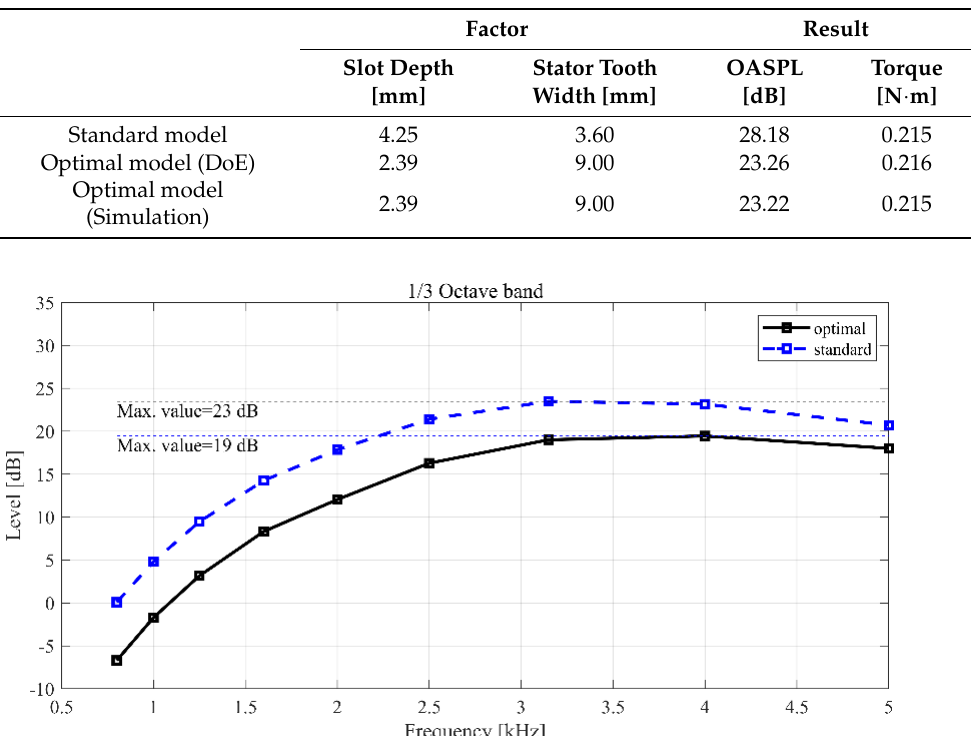
Figure 13. Desirability chart of design variable for optimization to maximize torque and minimize OASPL. Table 9. Comparison of standard model and optimal model. Table 9. Comparison of standard model and optimal model.